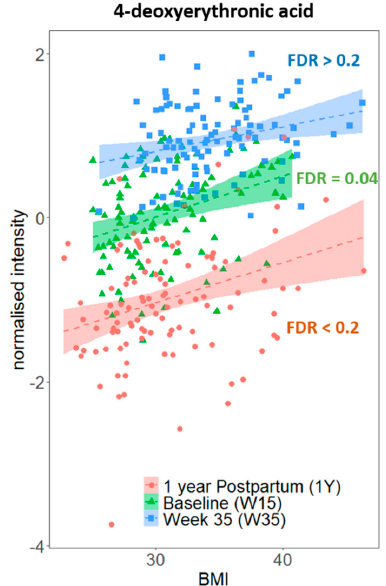
Figure 1. Relationship between urinary 4-deoxyerythronic acid and BMI at three different sampling timepoints. Signal integrals were normalized to median-fold change and log-transformed, and Pearson’s correlation p -values before multiple testing correction are shown. FDR, false discovery rate.